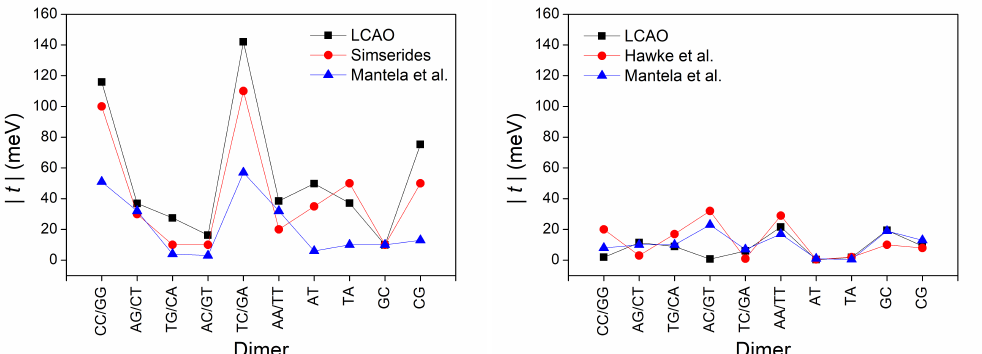
Figure 8. The absolute values of transfer parameters for all possible combinations of successive base pairs for holes ( left ) and for electrons ( right ). We show the transfer parameters obtained from our LCAO calculations using all valence orbitals, as well as the corresponding transfer parameters found in Reference [55] (for holes, estimation from various articles in bibliography), in Reference [29] (using only 2p z orbitals) and in Reference [52] (for electrons, using only 2p z